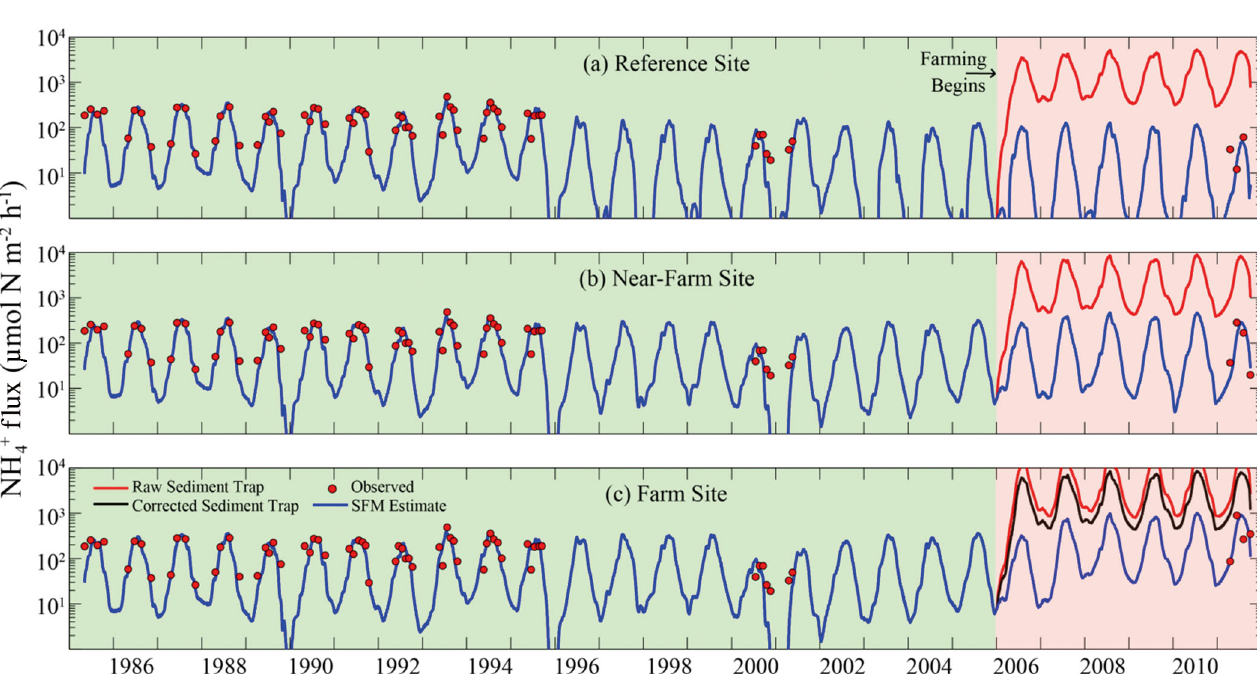
Fig. 4. Time-series (1985−2011) of modeled (lines) and observed (red circles) NH 4+ fluxes at (a) reference, (b) near-farm, and (c) farm sites. Green and red shading indicates pre- and post-oyster farming periods, respectively. Red line: uncorrected raw sediment trap estimates, black line: farm site sediment trap estimates corrected for resuspension, blue line: deposition esti- mated by sediment flux model (SFM) by fitting deposition to the observed sediment–water NH 4+ fluxes